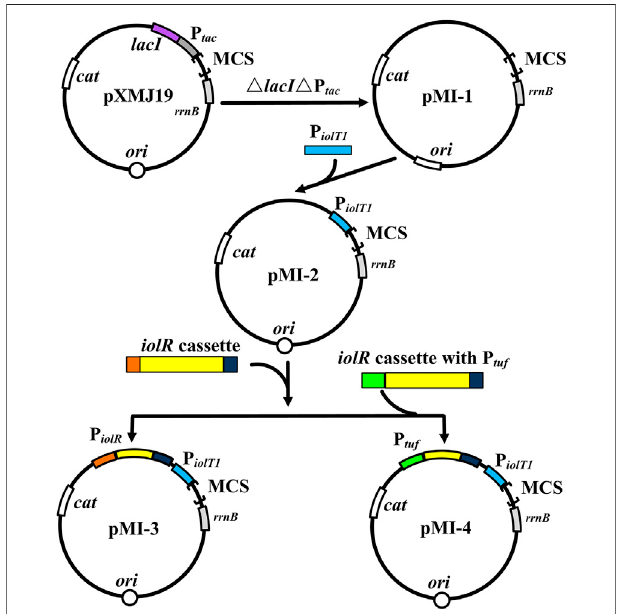
FIGURE 2 | Construction of pMI-4. MCS, multiple cloning sites; cat , chloramphenicolresistancegene; rrnB ,thetranscriptionalterminator;P tac , tac promoter; lacI , repressor LacI of P tac -encoding gene; ori , the origin of replication for C. glutamicum ; P iolT1 , iolT1 promoter; iolR cassette, fragment comprises promoter, encoding sequence, and terminator of iolR ; P tuf , promoter of the gene encoding elongation factor